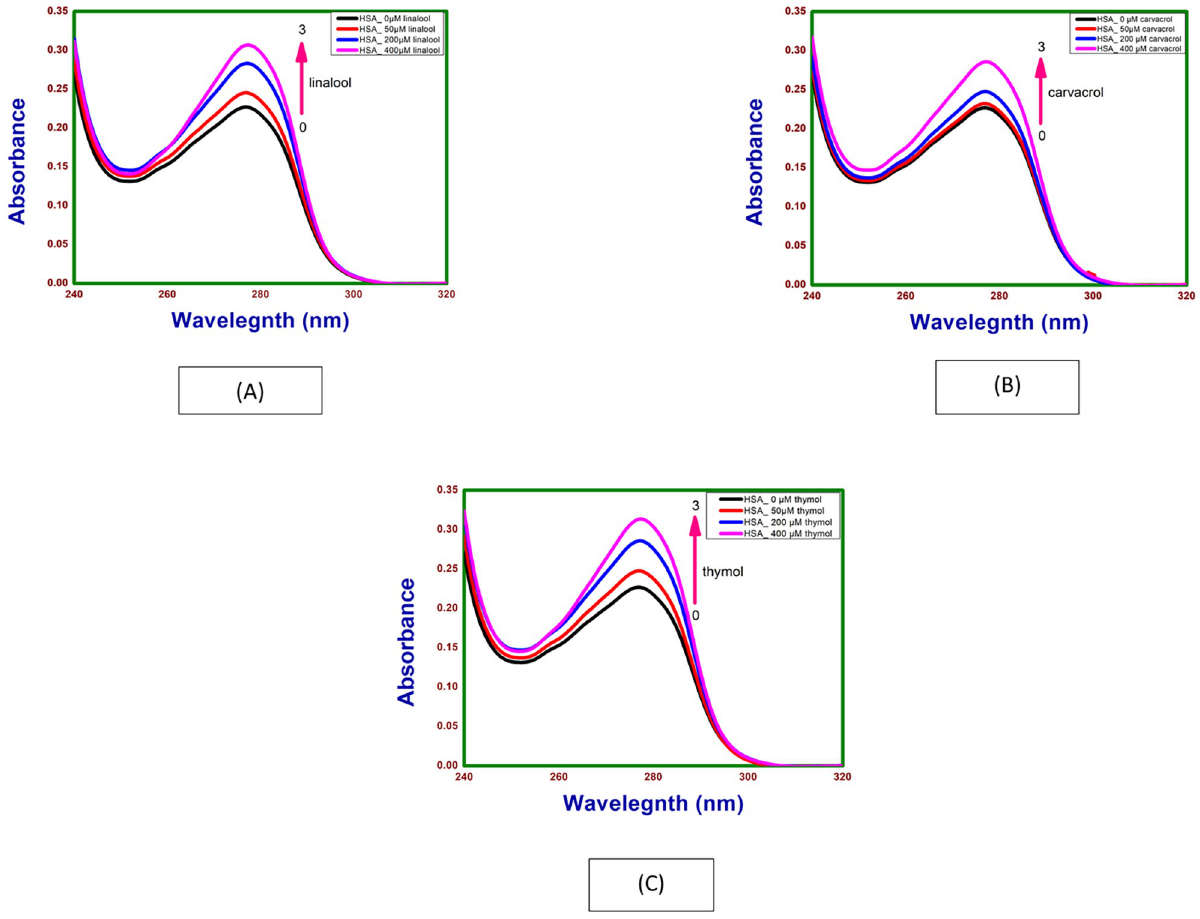
Fig 5. Absorption spectra of HSA as a function of (A) thymol, (B) carvacrol, and (C) linalool concentrations at 298.15 K and pH 7.4.